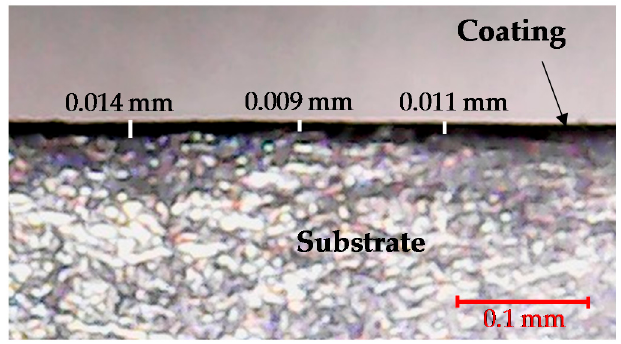
Figure 5. Cross-section of nondamaged electrodeposited coating layer.